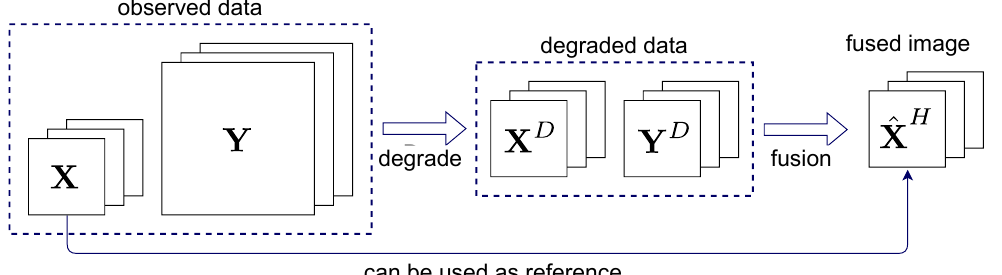
Figure 2. To obtain a reference image, the observed data are reduced in resolution by their respective resolution ratio. Then, the observed lower resolution image can be used as the reference